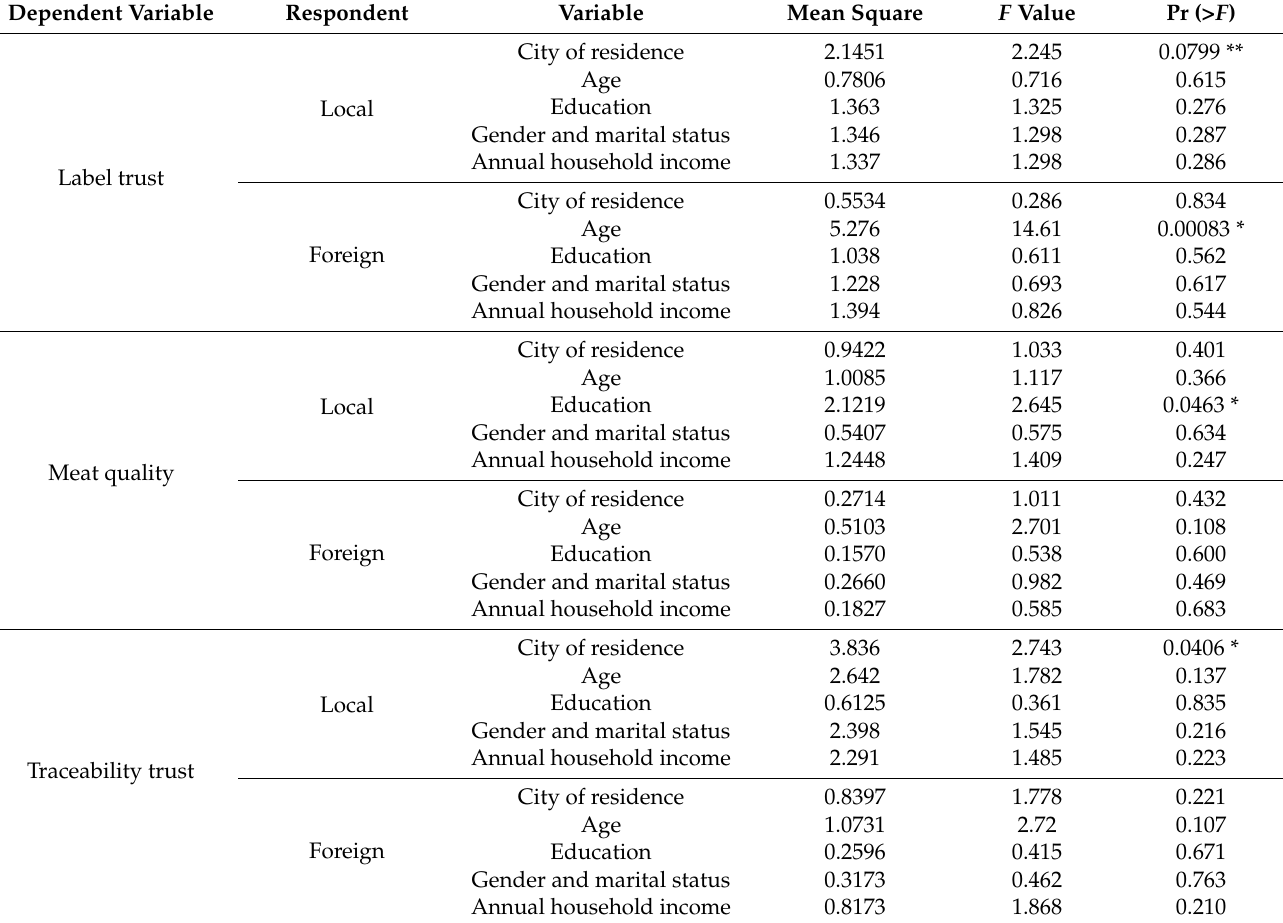
Table 4. One-way ANOVA tests for treatment respondents’ characteristics on perception